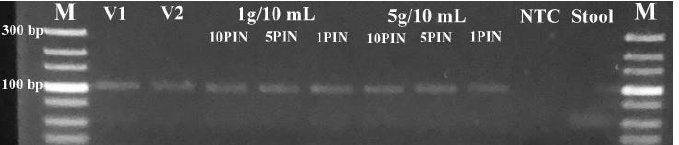
Figure 5. Agarose gel electrophoresis pictogram showing the correct DNA band sizes for both